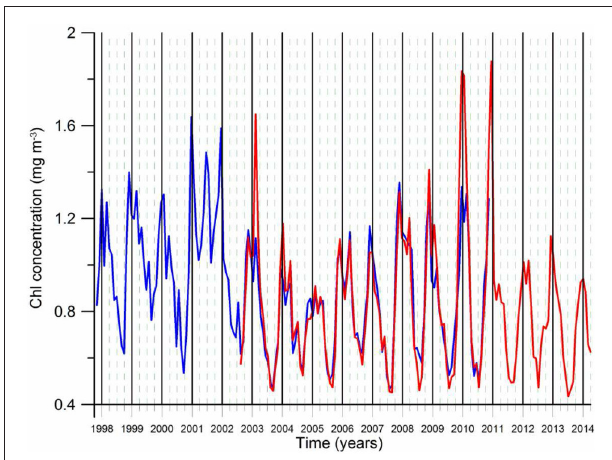
FIGURE 8 | The monthly-mean chlorophyll-a concentration variation of the post-eutrophication phase (1998–2013) averaged for the region 30–41 ◦ E longitude and 41–45 ◦ N latitude. The data are retrieved from the SeaWiFS (blue) and the MODIS (red) ocean coor